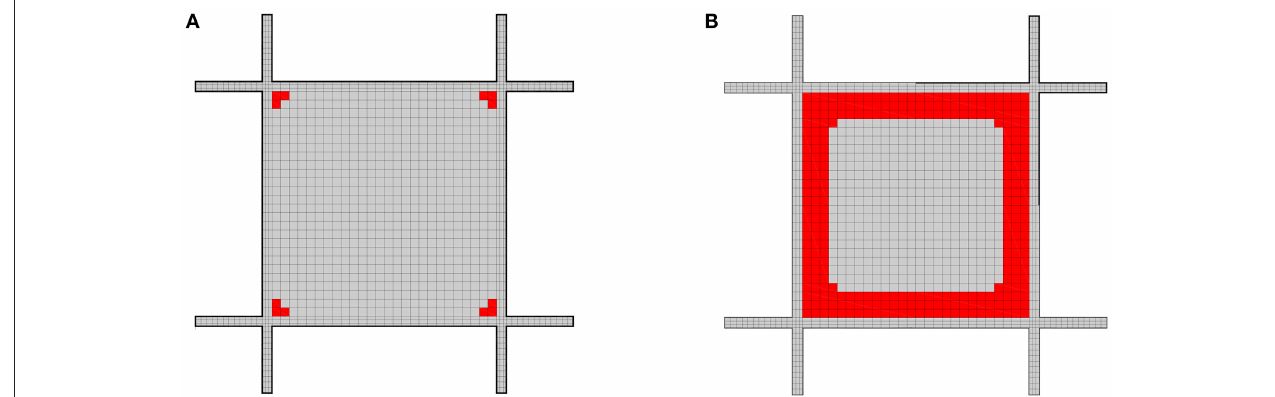
FIGURE 6 | Cracking propagation on the top surface at the: (A) beginning and (B) end.